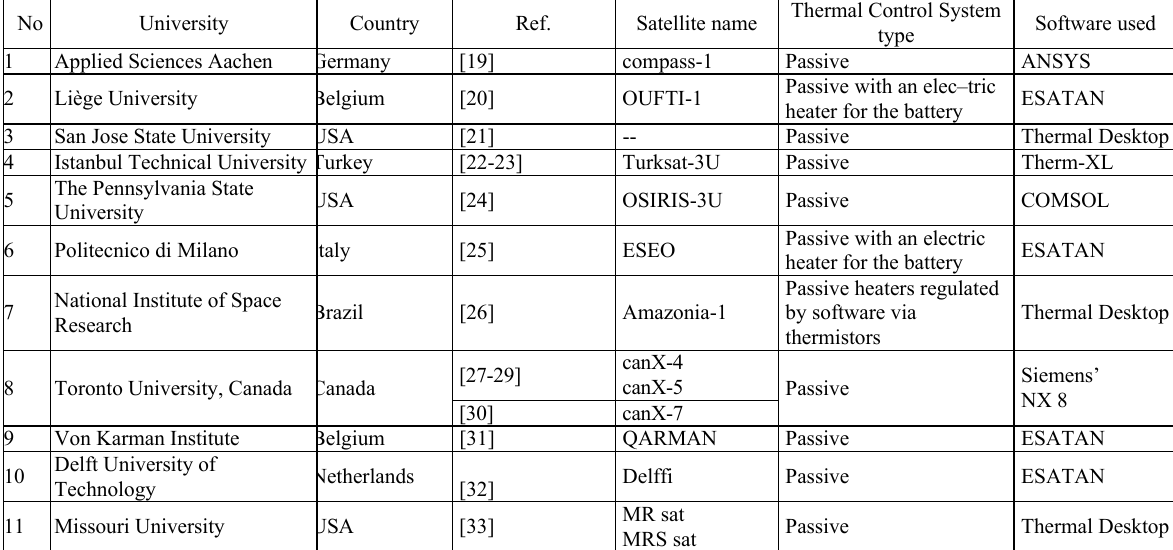
Table 2 Summary of university activities in small satellites thermal control No